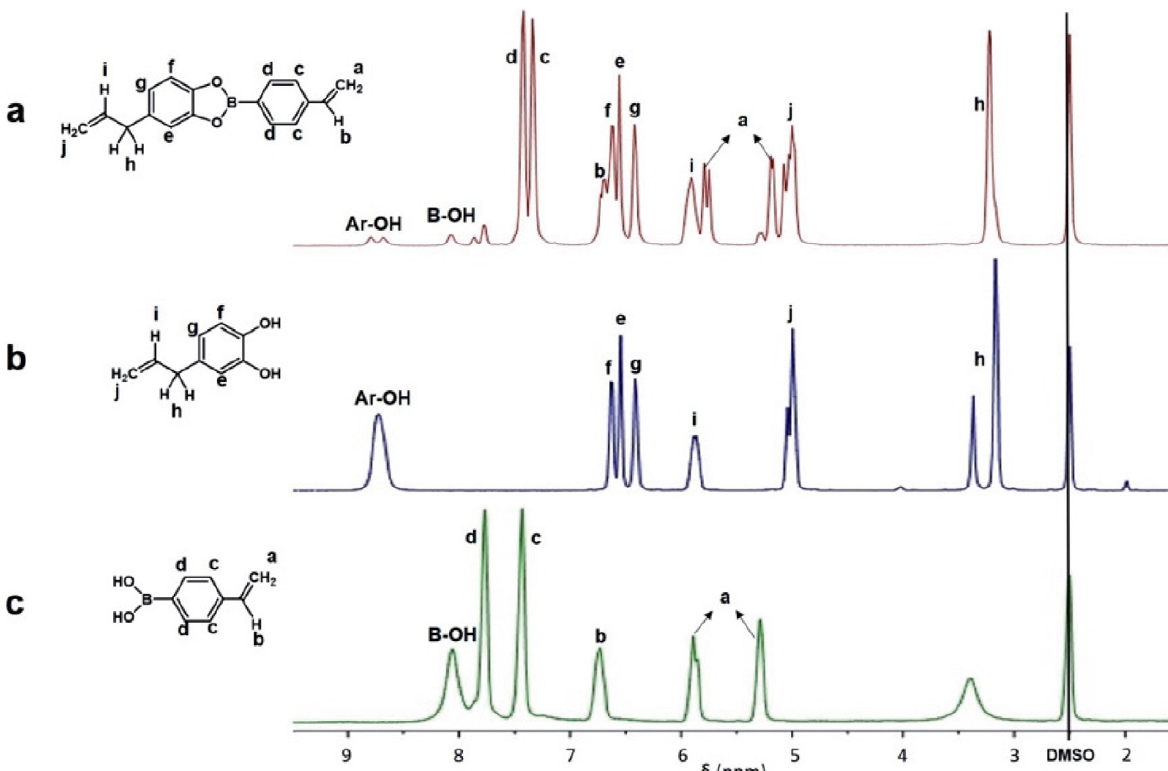
Figure 1. 1 H-NMR spectrum of a) CRX-3 b) 4-allylcatechol c) 4-vinylphenyl boronic acid.